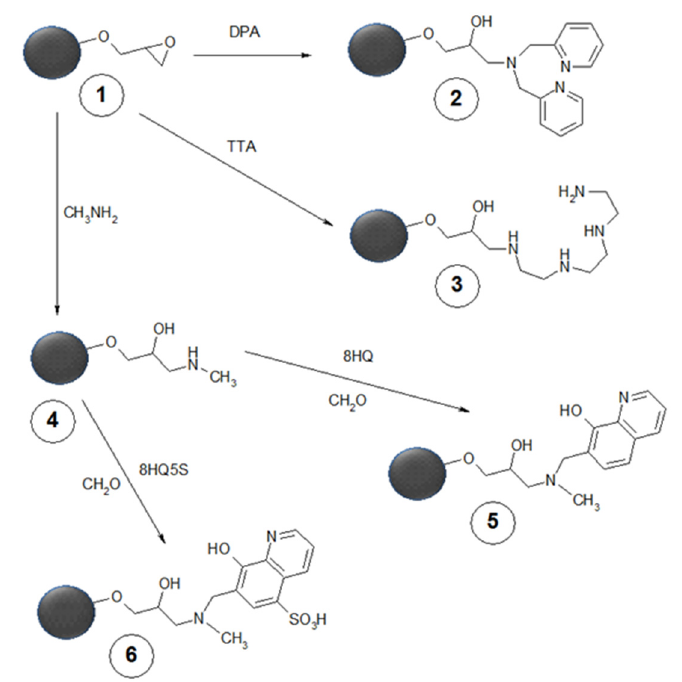
Figure 7. Macroreticular copper scavengers (2,3,5,6) for oral use synthesized from poly(glycidyl methacrylate-co-ethylene methacrylate) (1); the Mannich condensation requires secondary amine intermediate 4. Reprinted from Reference [141], with permission. Copyright 2021 Elsevier.